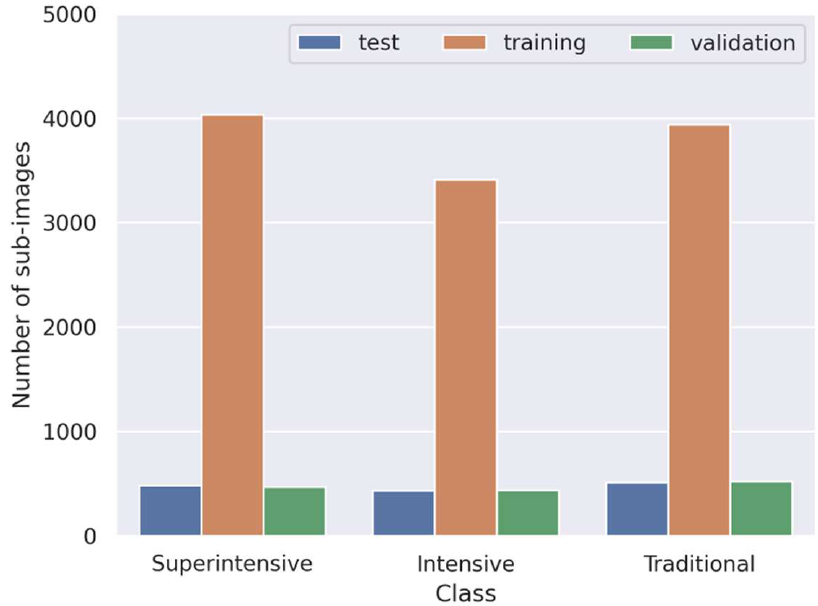
Figure 6. The distribution of the dataset of mini-crops. Four mini-crop sets were generated for a set of values of (Hm, Wm, s) (50, 50, 5; 80, 80, 8; 100, 100, 10; 120, 120, 12). Figure 7 shows examples of different mini-crops of 80 × 80 px. The differences between classes can be easily observed. While the super-intensive crops tend to be formed by lines of cultivation, the intensive and traditional crops have sparse olives. It was imposed for every mini-crop that it must contain a C TH percentage of cultivable area to avoid unnecessary, uninformative images; namely, the value selected was 0.1. This value was set heuristically according to the resolution of the crops with scarce FCC zones. We have observed that values lower than 0.1 will overfill the network with too many void images. This thresholding also alleviates training times since the need of an additional ‘void’ label